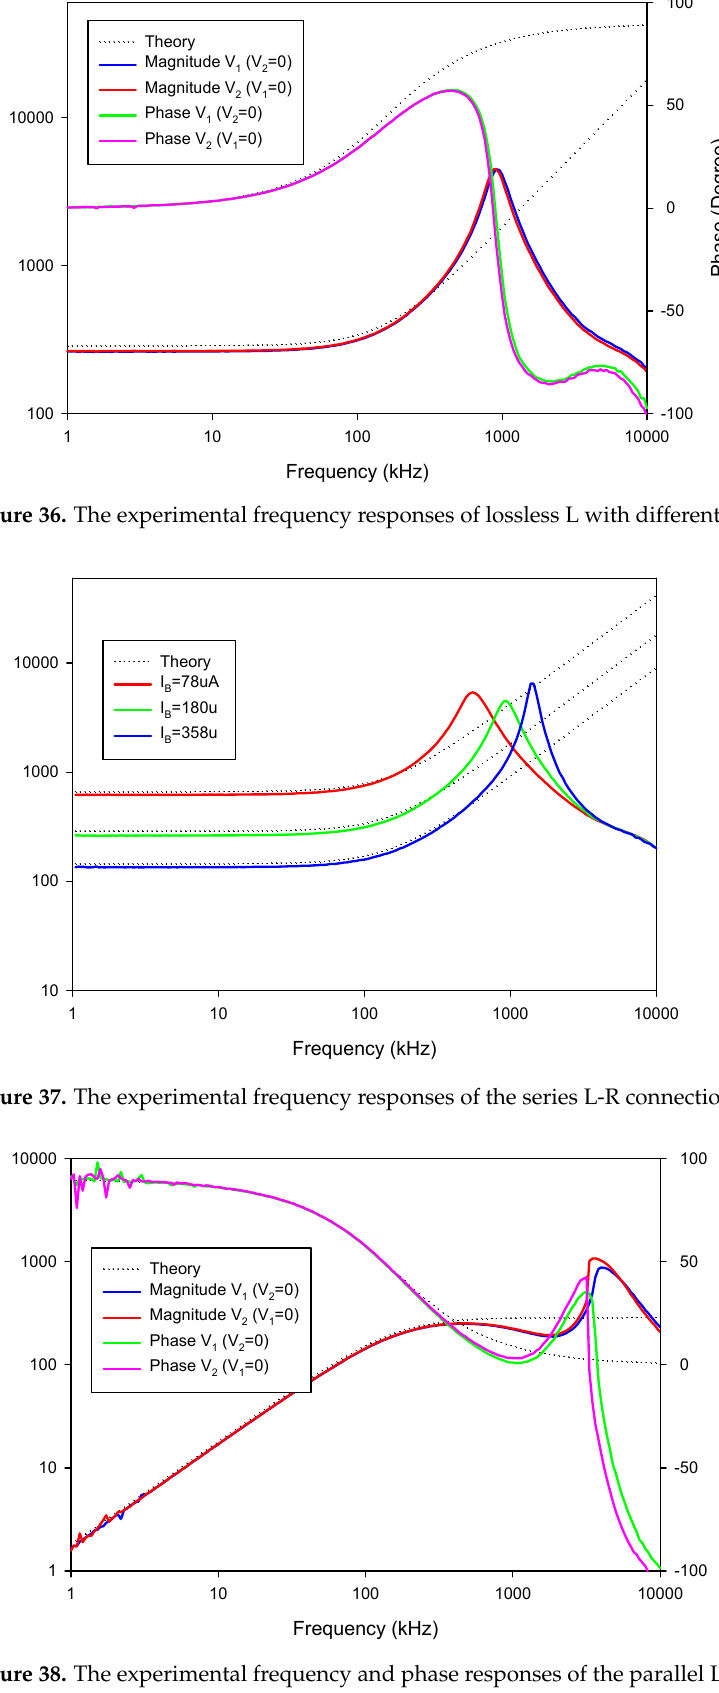
Figure 38. The experimental frequency and phase responses of the parallel L-R connection.